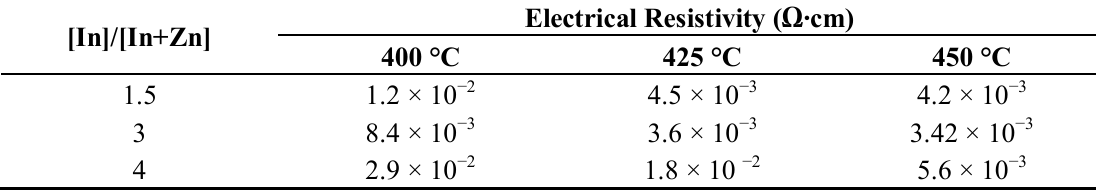
Table 1. Room temperature electrical resistivity of ZnO:In thin films deposited at different growth